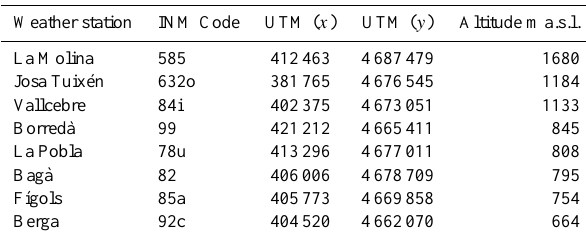
Table 1. Location of weather stations in or near the headwaters of the Llobregat River